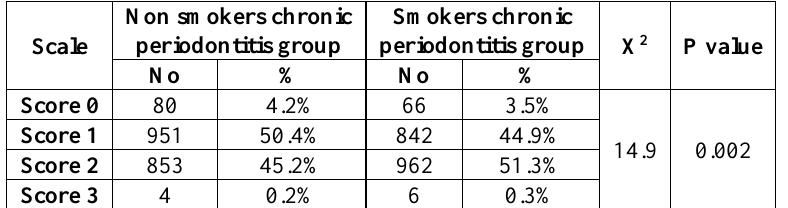
Table 3: Number and percentage (in sites) of PPD scores and Chi-square test of smokers and